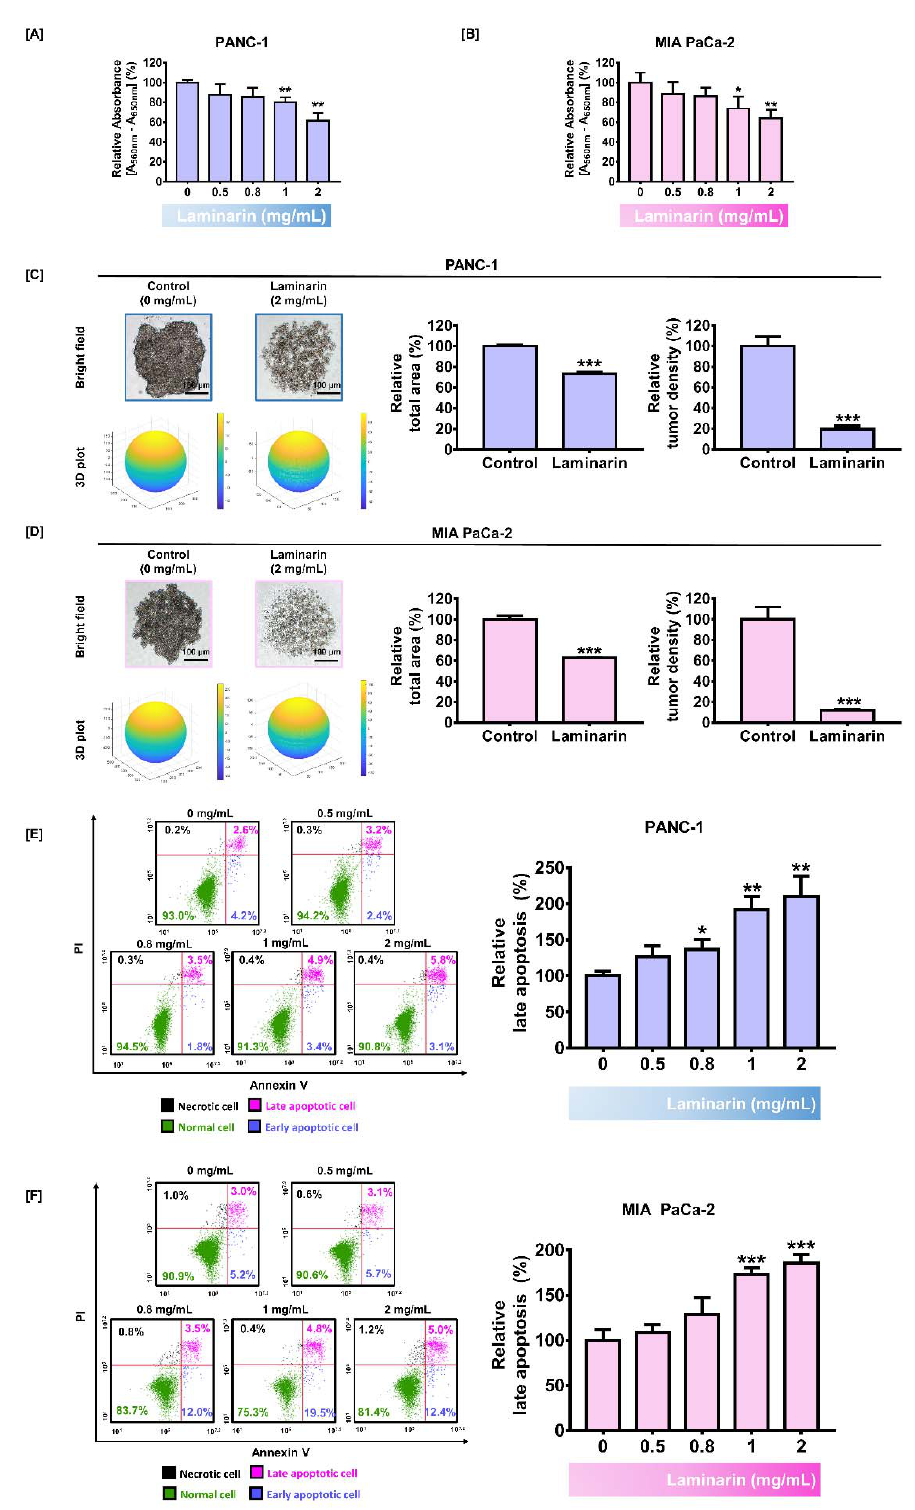
Figure 1. Antitumor effects of laminarin on PC cells. ( A , B ) Relative cell proliferation decreases with increasing laminarin concentrations of 0, 0.5, 0.8, 1, and 2 mg/mL. ( C , D ) Spheroid formation in cells without and with laminarin. Scale bar: 100 μ m. ( E , F ) Apoptotic cell death analyzed using Annexin V and propidium iodide. Purple dots (upper right) in dot plots indicated late apoptotic cells. (* p < 0.05, ** p < 0.01, and *** p < 0.001; laminin vs. control). All experiments were conducted in triplicate.